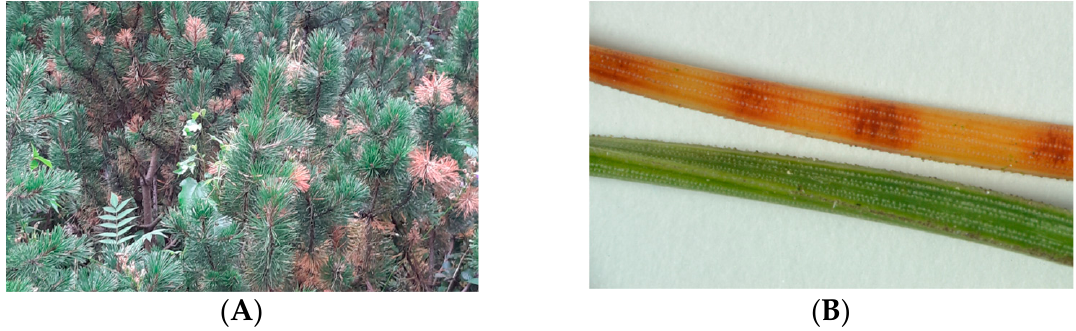
Figure 1. Yellowed discoloration of needles of Pinus mugo caused by D. septosporum in the greenhouse surrounding the Forest Research Institute in S˛ekocin Stary, Poland ( A ). Symptoms of red band pine disease: needles with brown, necrotic tissue of D. septosporum developing under the epidermis of P. mugo needle ( B ). Photos by C. Bystrowski.